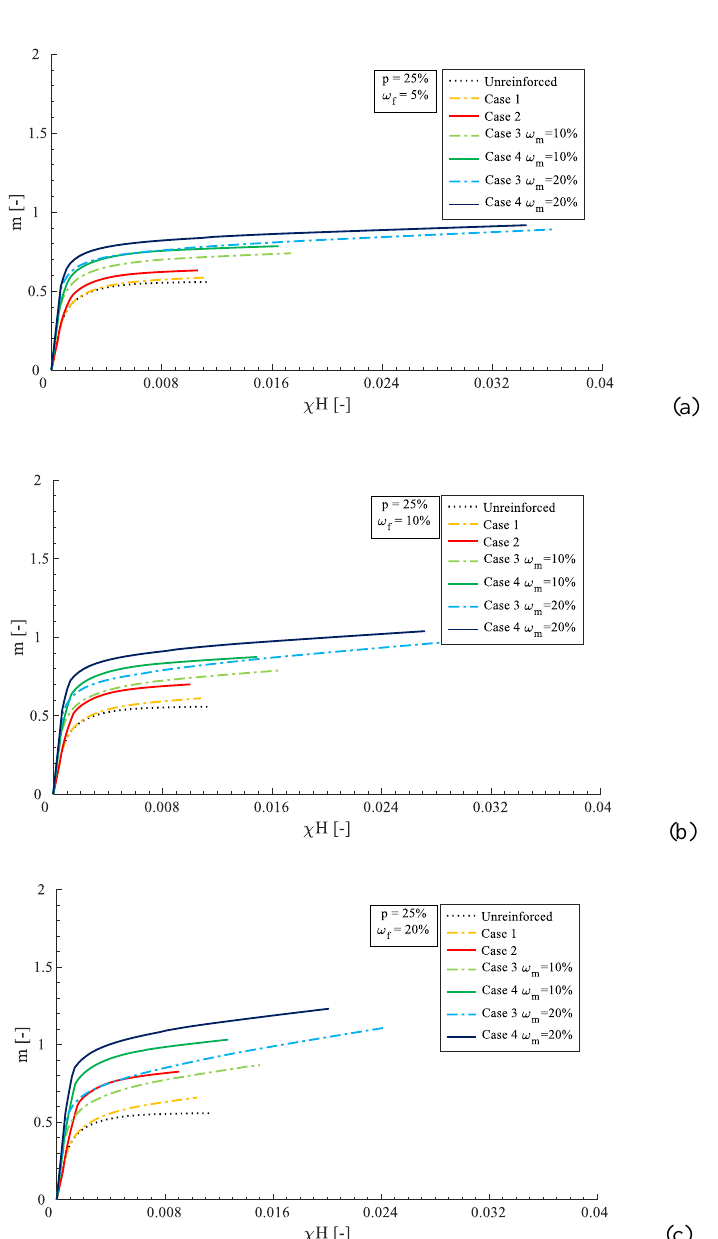
Figure 8. Bending moment–curvature diagrams for all 4 cases: ( a ) ω f is fixed (5%); ( b ) ω f is fixed (10%); ( c ) f is fixed (20%).